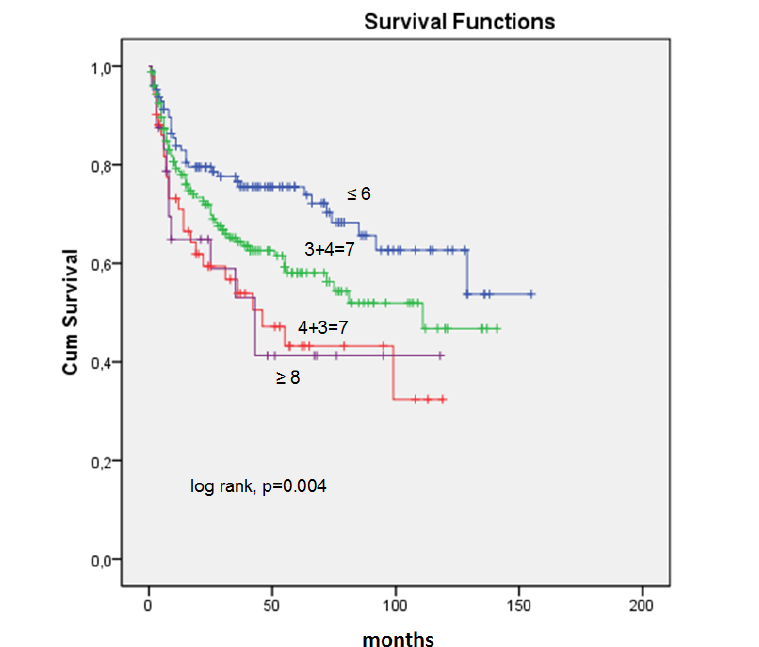
Figure 3 - Kaplan-Meier product-limit analysis shows time to PSA biochemical progression-free outcome by Gleason score ≤ 6, 3+4=7, 4+3=7, and ≥ 8 in surgical specimens. Cum, cumulative.